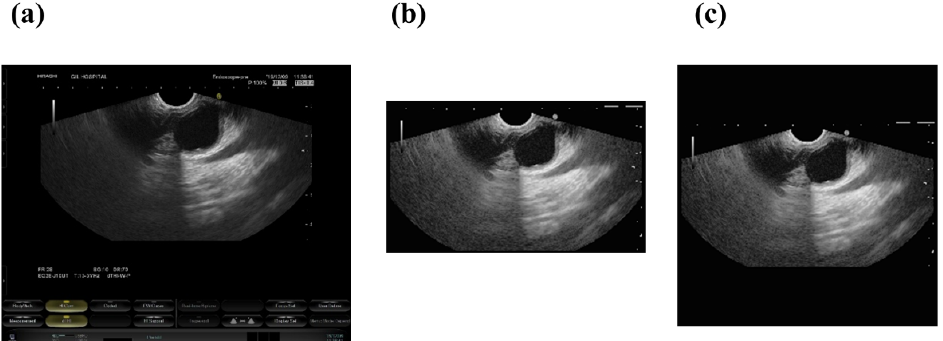
Figure 1. Image processing and zero-padding of the endoscopic ultrasonography images. ( a ) Original image, ( b ) Histogram equalized and cropped image, and ( c ) padded image.